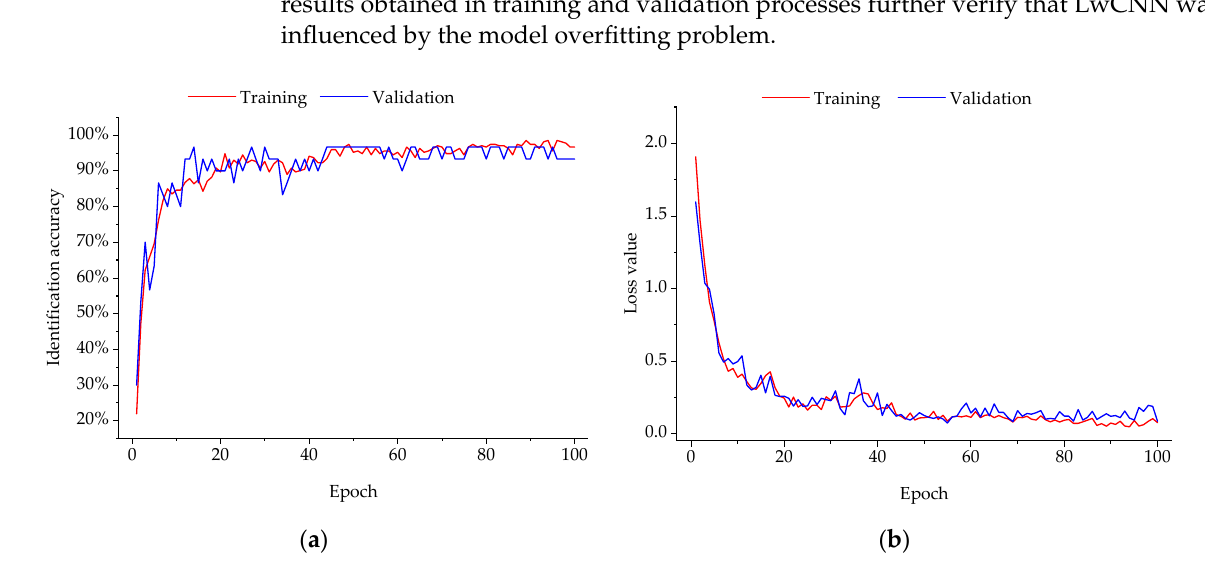
Figure 7. The identification accuracies and loss values at different epochs in a typical trial of training and identification processes: ( a ) the variation of identification accuracy in a typical trial; ( b ) the variation of loss value in a typical trial.